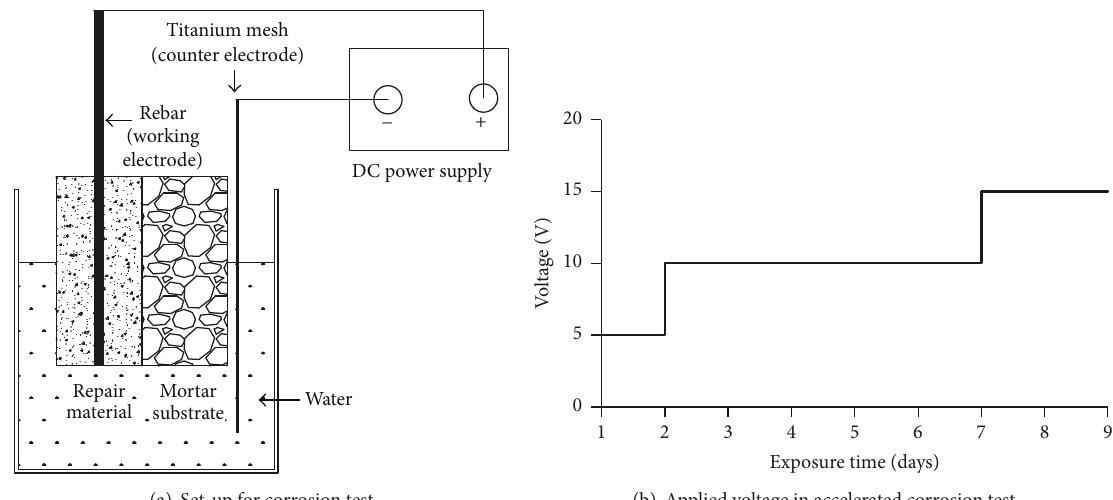
Figure 4: Accelerated corrosion test.